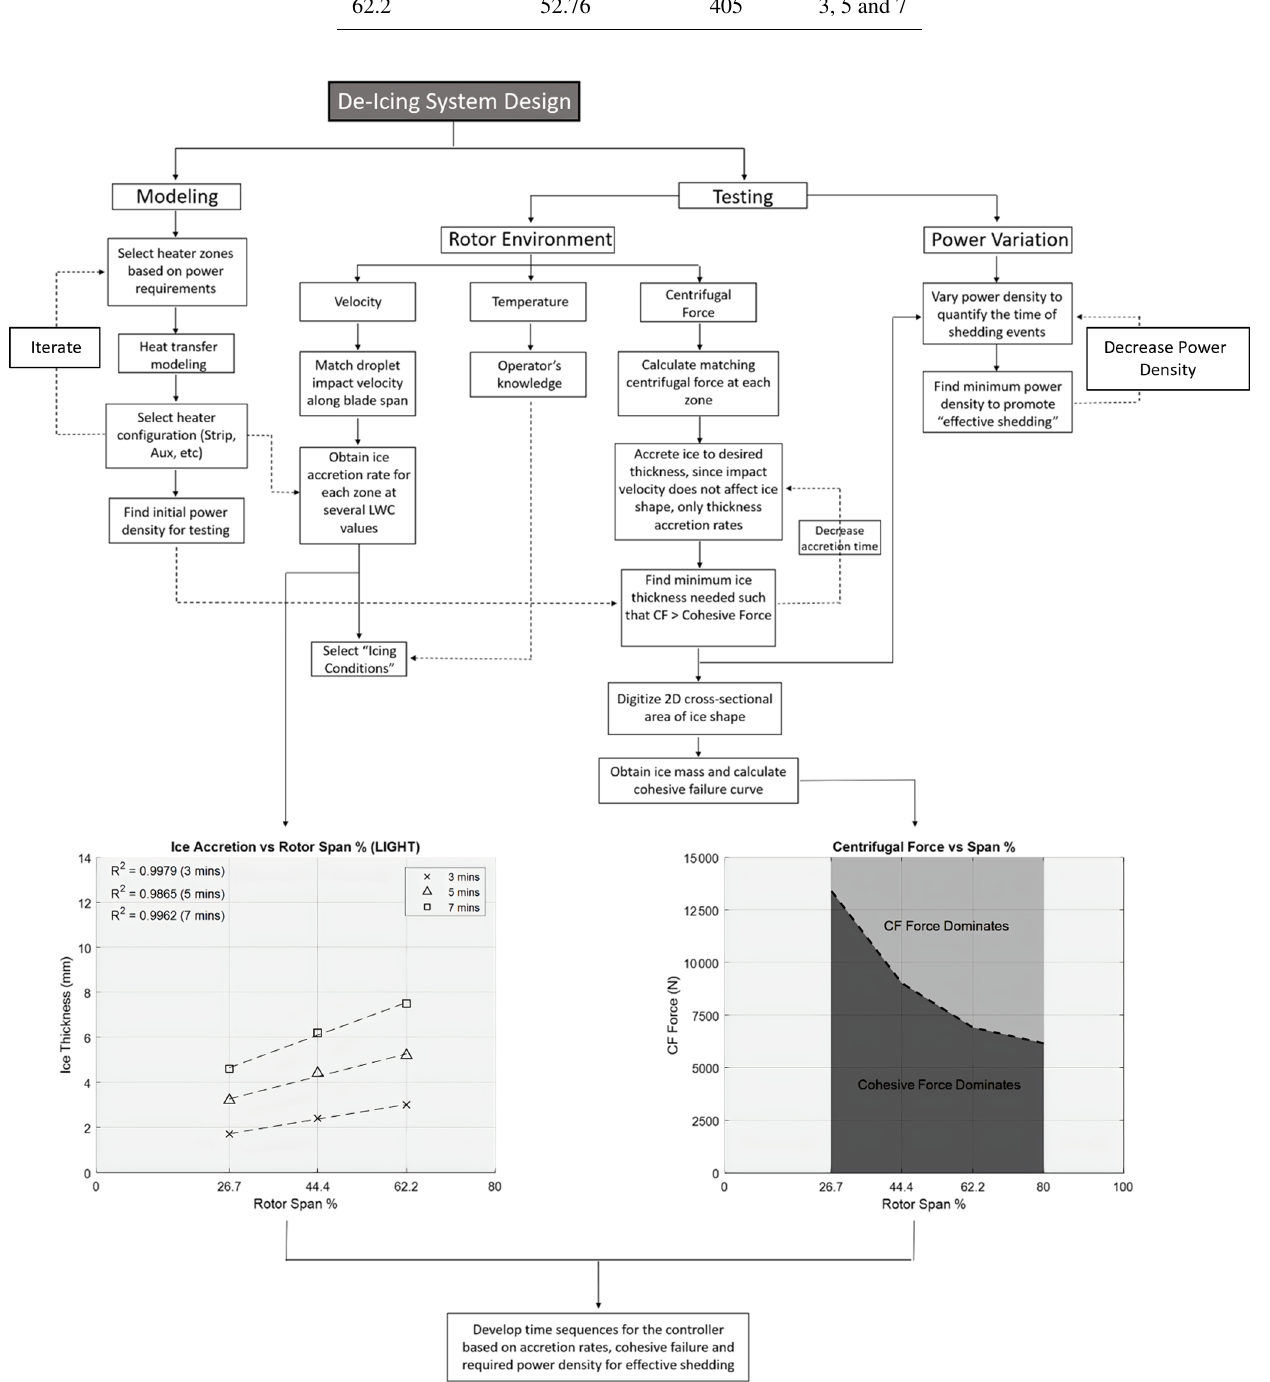
Figure 11. Flowchart identifying the design of the deicing IPS procedure.